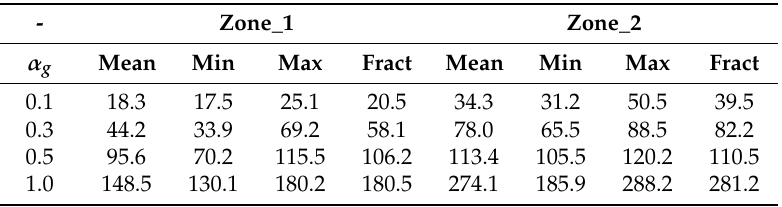
Table 7. Down-aisle displacements at 20th level, with NLTH (in